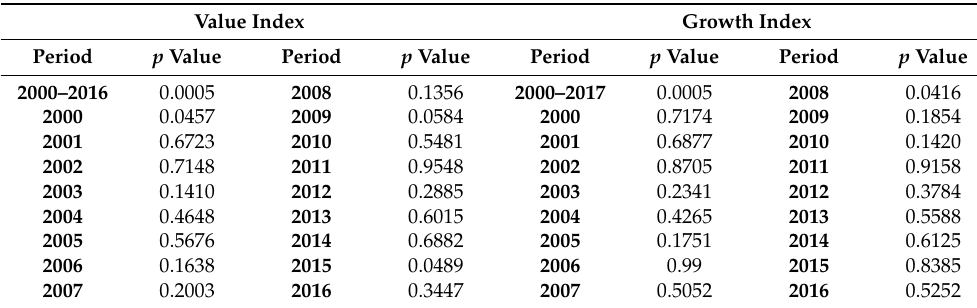
Table 3. Anderson–Darling test results ( p values).